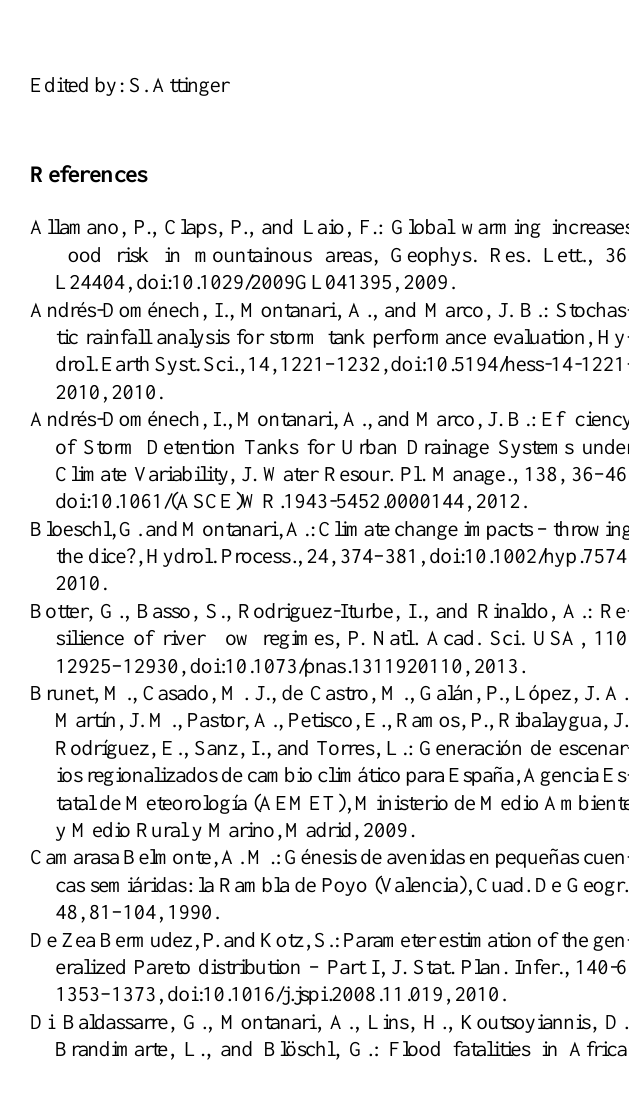
Figure 3. Annual maximum flood quantile variations for scenarios defined in Table 1 and ξ = 0.05 confidence interval for scenario 0 peak flow distribution (shaded area). Catchment parameters are set to S/µ V = 3.5 and t C =